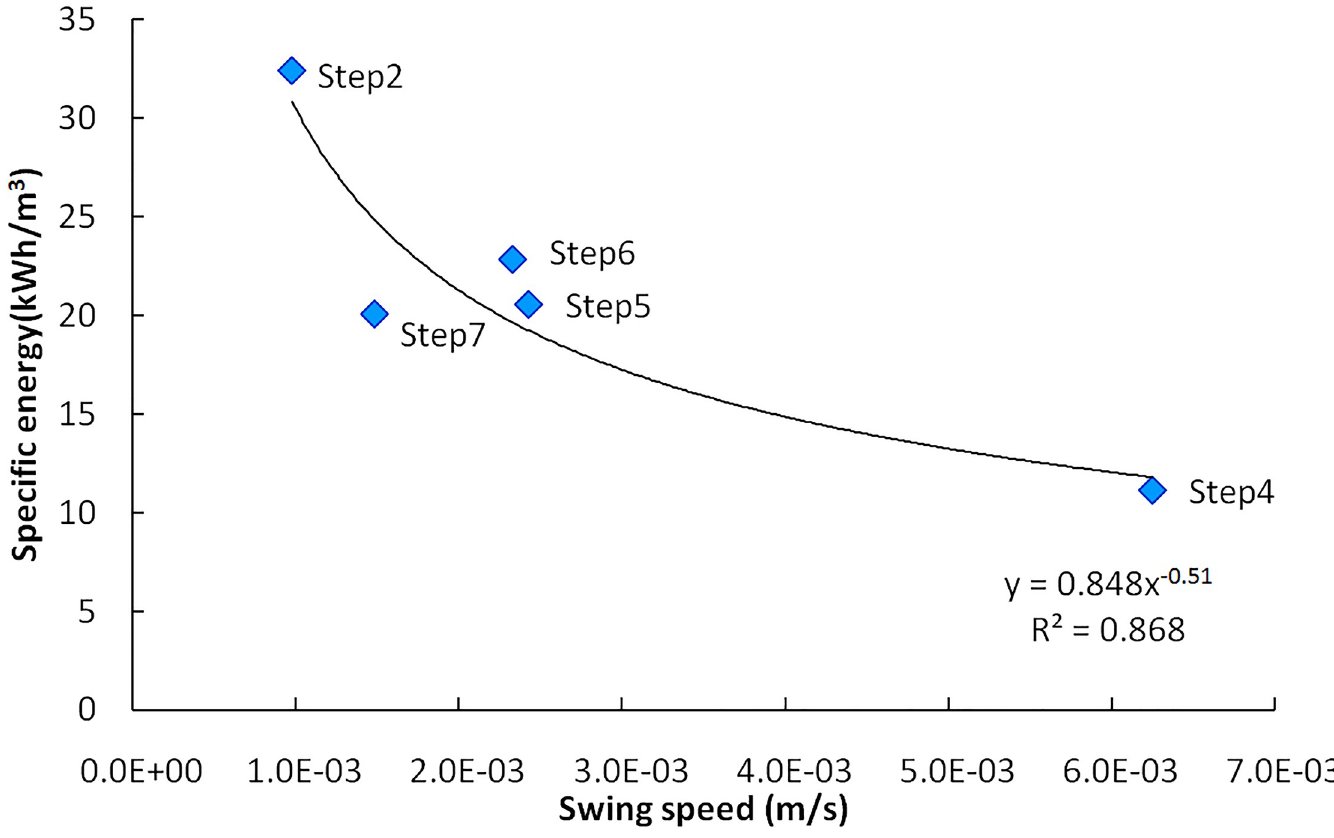
Fig 30. Rock cutting specific